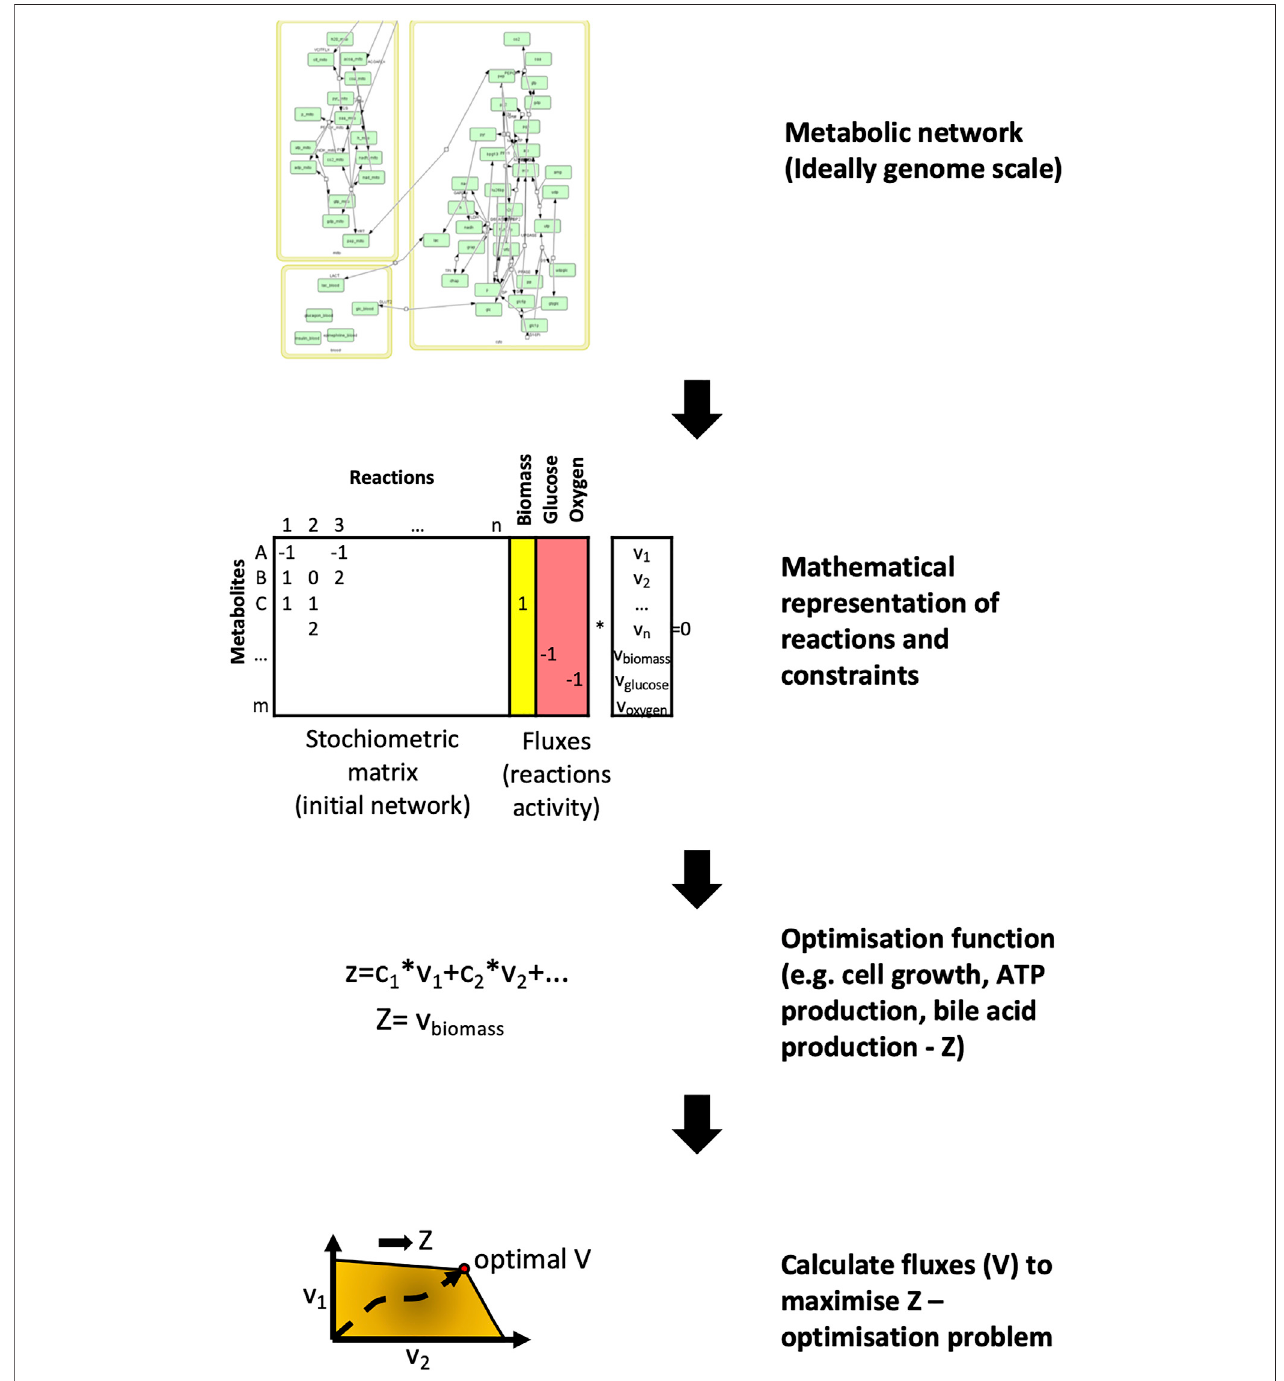
FIGURE3| Fluxbalanceanalysis-thebasicsofmetabolicnetworkmodelling.Formetabolicnetworkstheinitialstepinvolvescollectingthemetabolicreactionsthat formthenetwork.Thesereactionsarerepresentedbyastoichiometricmatrixwhereeachreactionisrepresentedbythenodesandmetabolitesbytheedges.Theaimof fl uxbalanceanalysisisto fi ndtheoptimalvector( fl ux)thatyieldsthemaximumoutputforagivenmetaboliteormetabolites(Z)throughthesereactions.Forillustration,the glucose metabolism was used from Köenig et al., 2012 (König et al., 2012).